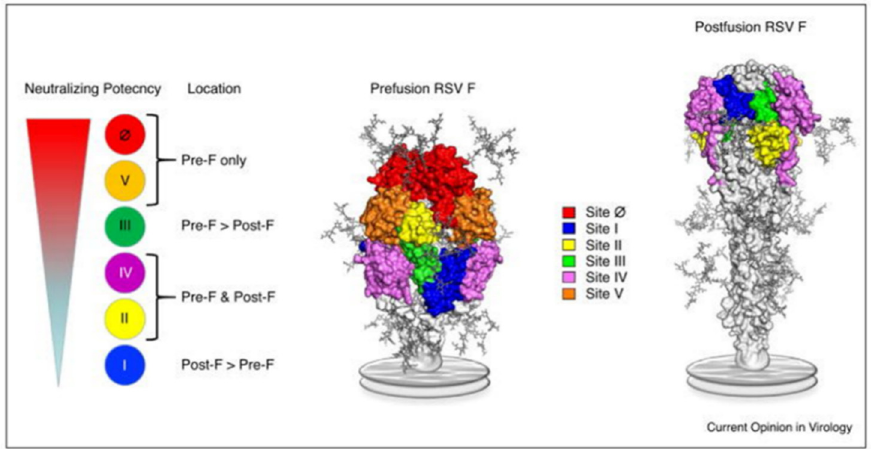
Figure 1. Location of the major antigenic sites on pre-F and post-F conformations of RSV. This figure is adopted from Graham [6] (The copyright has been obtained from the corresponding